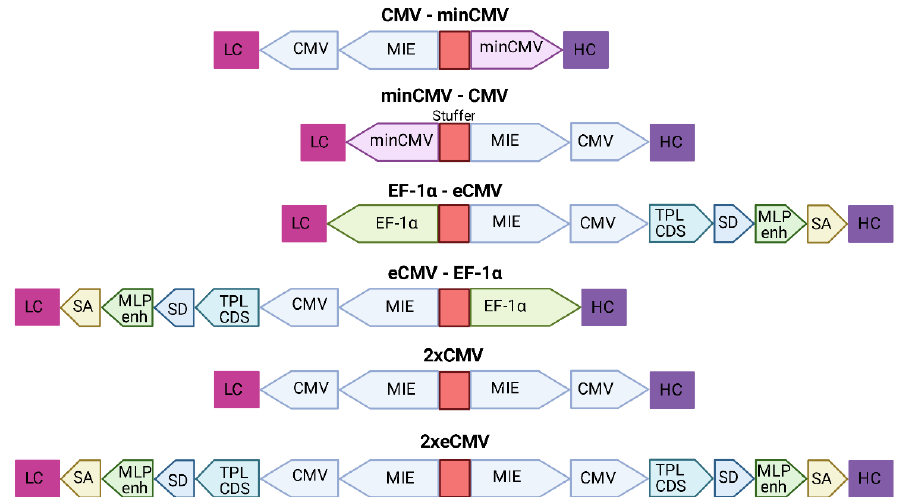
Figure 2. Overview of the different bidirectional combinations tested. The 200-bp stuffer sequence is marked in red for each construct. Abbreviations: minimal CMV (minCMV), cytomegalovirus promoter (CMV), enhanced CMV (eCMV), major immediate early enhancer (MIE), human translation elongation factor 1 alpha (EF-1α), adenoviral tripartite leader sequence (TPL CDS), adenovirus major late promoter enhancer (MLP enh.), splicing donor site (SD), splicing acceptor site (SA), light chain (LC), heavy chain (HC).